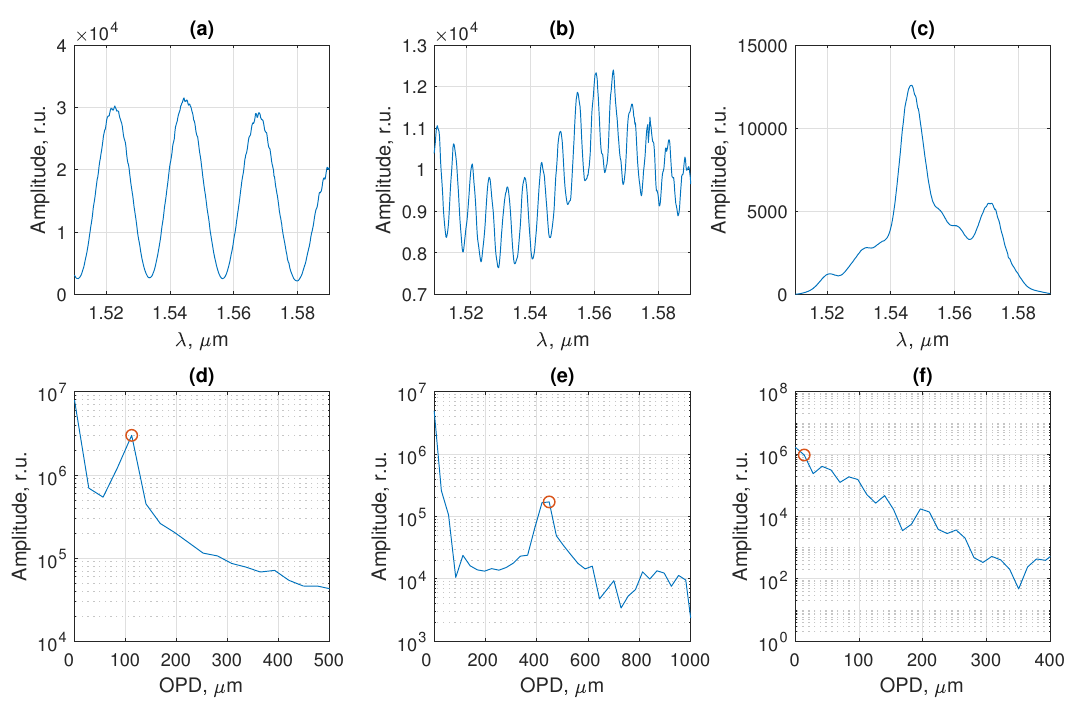
Figure 4. Examples of optical spectra and their FFTs of FPI ( a , d ); OCT ( b , e ) and SMS ( c , e ) sensors. Horizontal scales in ( d – f ) correspond to optical path length in air (note that OPD of FPI and OCT system is doubled air gap and tissue depth, respectively). Circles in ( d – f ) indicate FFT samples, from which phase the target signal was